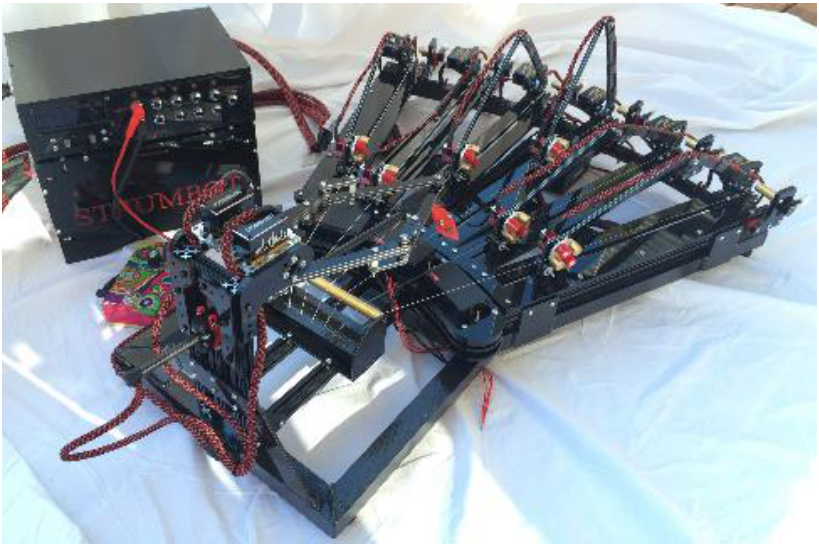
Fig. 3. StrumBot – an integrated six-string guitar